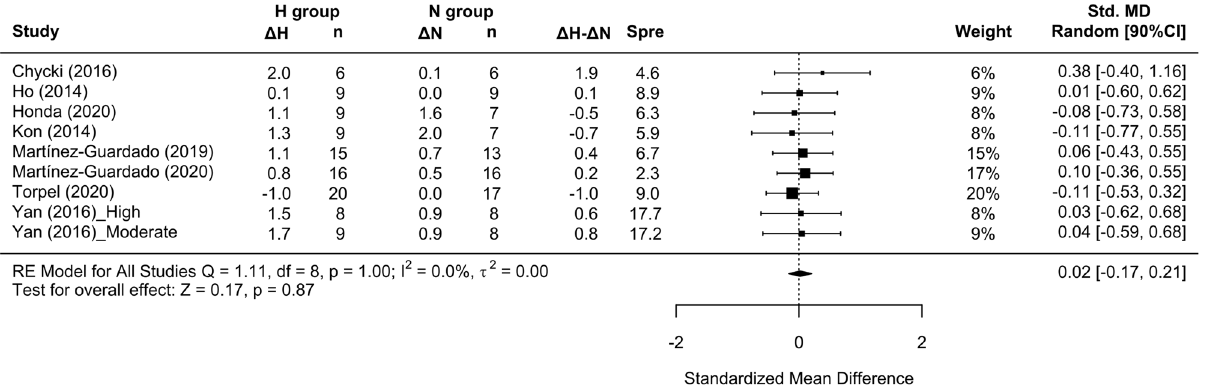
Figure 4. Forest plot of the standardized mean differences of the total effect of the resistance training program between-conditions (hypoxic [H] group vs. normoxic [N] group) on lean mass. Δ: mean differences between post–pre in H and N or between H–N; n: sample size; Spre: mean baseline standard deviation; Std. MD: standard mean difference; RE: random effect’s model; CI; confidence interval; Q: test statistic for the test of heterogeneity; df: degrees of freedom; p : p value; I 2 : I 2 test; τ 2 : tau 2 test; Z: z value. Yan et al. 44 study provides a group with moderate hypoxia and another with high